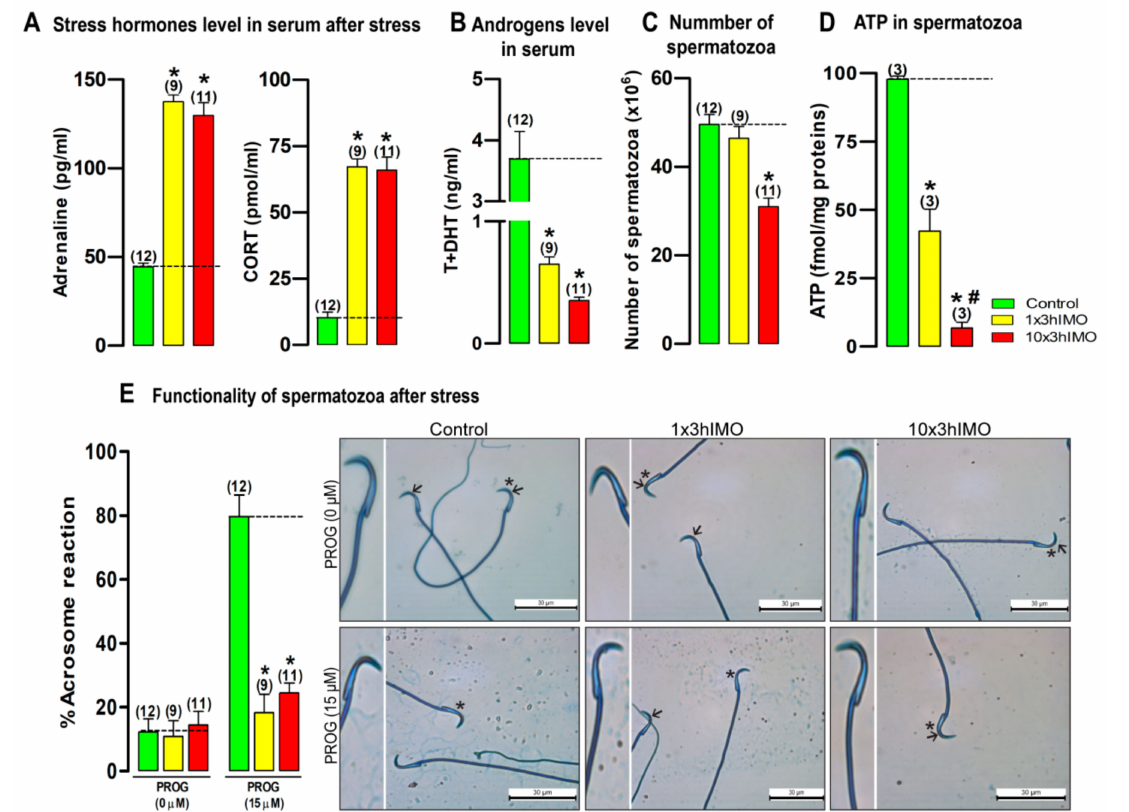
Figure 1. The repeated psychophysical stress increases the level of stress hormones in circulation, but decreases androgens levels, as well as the functionality, ATP level, and number of spermatozoa. The circulating (serum) levels of ( A ) stress hormones adrenaline and corticosterone (CORT), as well as ( B ) androgens (testosterone + dihydrotestosterone, T + DHT) after psychophysical stress by immobilization. ( C ) The number of spermatozoa isolated from caudal epididymides of unstressed rats (control), rats subjected to acute immobilization (IMO) stress once, for 3 h (1 × 3hIMO), and rats subjected to repeat IMO of 3 h for 10 consecutive days (10 × 3hIMO). ( D ) ATP content in spermatozoa isolated from control, acutely (1 × 3hIMO) or repeatedly (10 × 3hIMO) stressed rats. ( E ) The functionality of spermatozoa (% of acrosome reacted spermato- zoa) isolated from control and acutely (1 × 3hIMO) and repeatedly (10 × 3hIMO) stressed rats. Capacitated spermatozoa were stimulated with progesterone (PROG 15 µ M) in parallel with spermatozoa not treated with progesterone (PROG 0 µ M). Blue staining in the acrosome region of the head indicated intact acrosome, whereas spermatozoa without blue staining in the acrosome region were considered to be acrosome reacted. Arrows indicate acrosome intact spermatozoa; scale bar 30 µ m. Star indicates spermatozoa magnified on the right panel. Data bars are mean ± SEM values of three independent in vivo experiments. Statistical significance was set at level p < 0.05: * vs. control group; # vs. 1 × 3hIMO